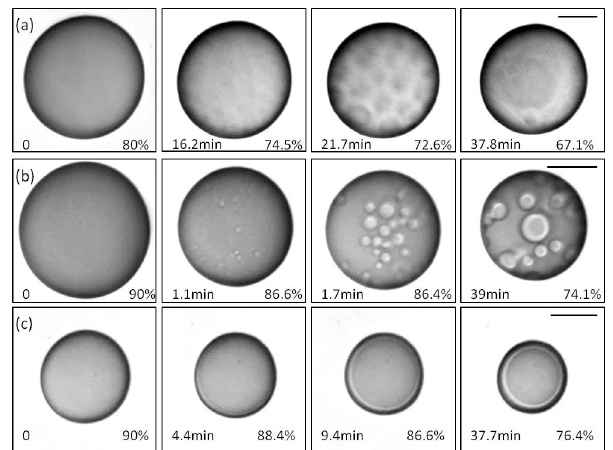
Fig. 7. Series of optical images for different LLPS mechanisms: (a) mechanism unclear (most probably growth and coalescence of organic lenses on the droplet surface) in a C6/AS/H 2 O particle with OIR=1:4, (b) nucleation-and-growth with subsequent coalescence in a C7/AS/H 2 O particle with OIR=6:1, and (c) growth of sec- ond phase from the particle surface in a C7/AS/H 2 O particle with OIR=1:6. The black bars represent